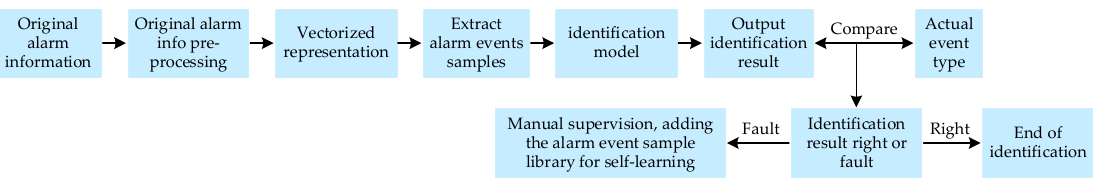
Figure 2. Grid monitoring alarm event identification process.